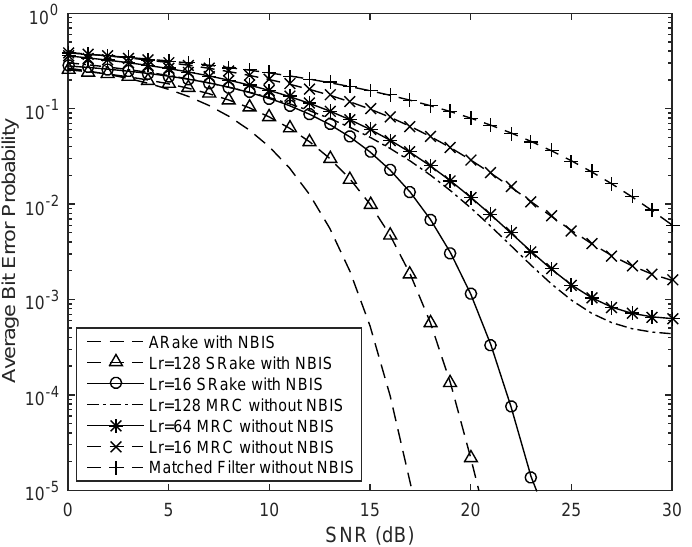
Figure 9. Normalized impulse response of the IEEE 802.15.4a CM5 channel model for the outdoor line of sight scenario.